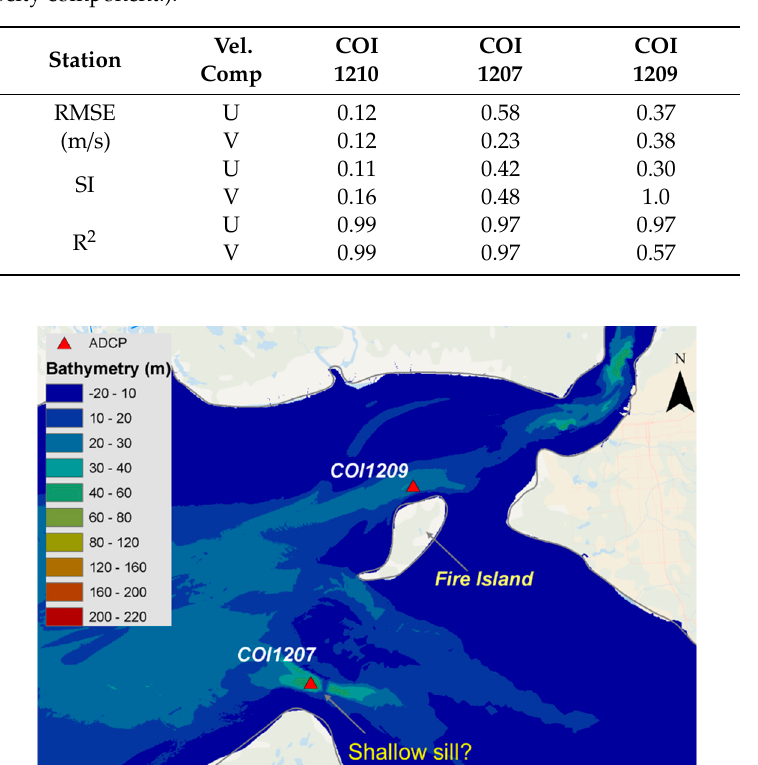
Table 4. Error statistics (RMSE and R2) for depth-averaged tidal currents at selected ADCP stations inside Cook Inlet. (The top row is for the east velocity (U) component and the bottom row is for the north (V) velocity component.).